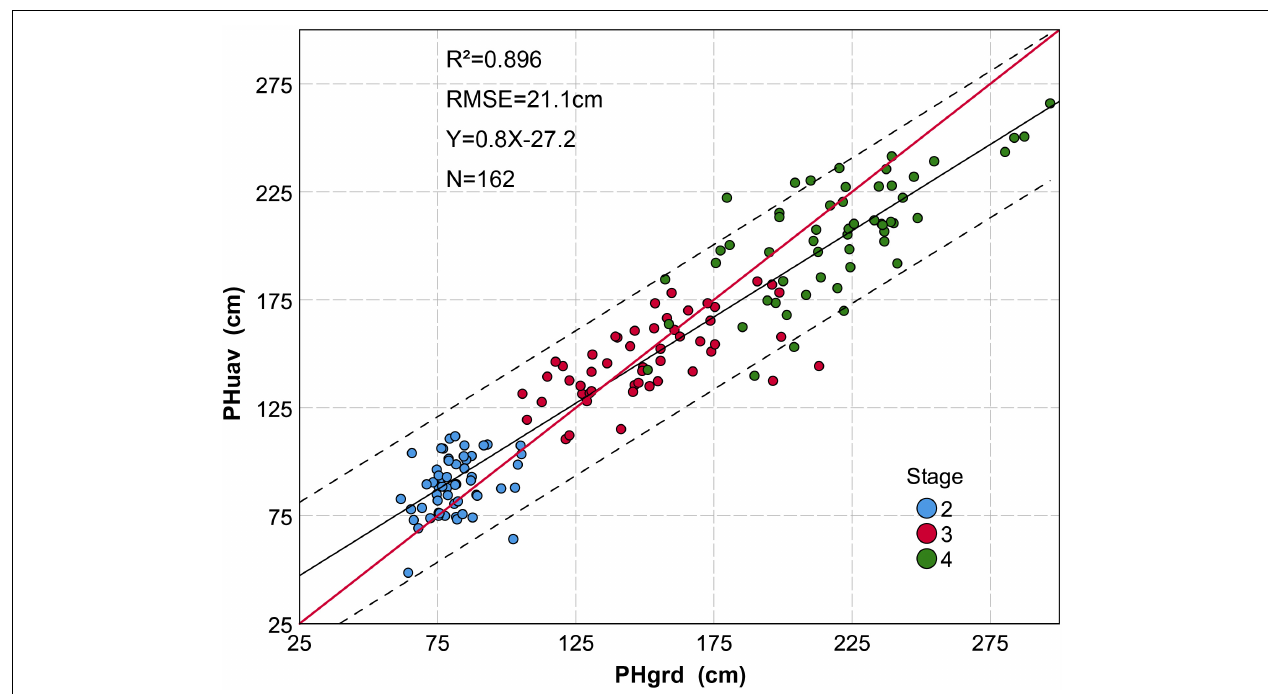
FIGURE 3 | Grouped scatter plot of plant height derived from a UAV-HTPP (PHuav) versus ground truth ruler measurements (PHgrd). Data are based on a subset (removing the data that is affected by lodging) of sampling plots measured during three growth stages. The black solid line represents the regression line, the red solid line an implied 1:1 relationship, and the dotted line represents 95% confidence interval. P -value < 0.001 at the 0.01 level (two-tailed). A total of 162 samples were taken from three different growth stages. The discrete degree of plant height during different growth stages is different. Data are more discrete during later stages of